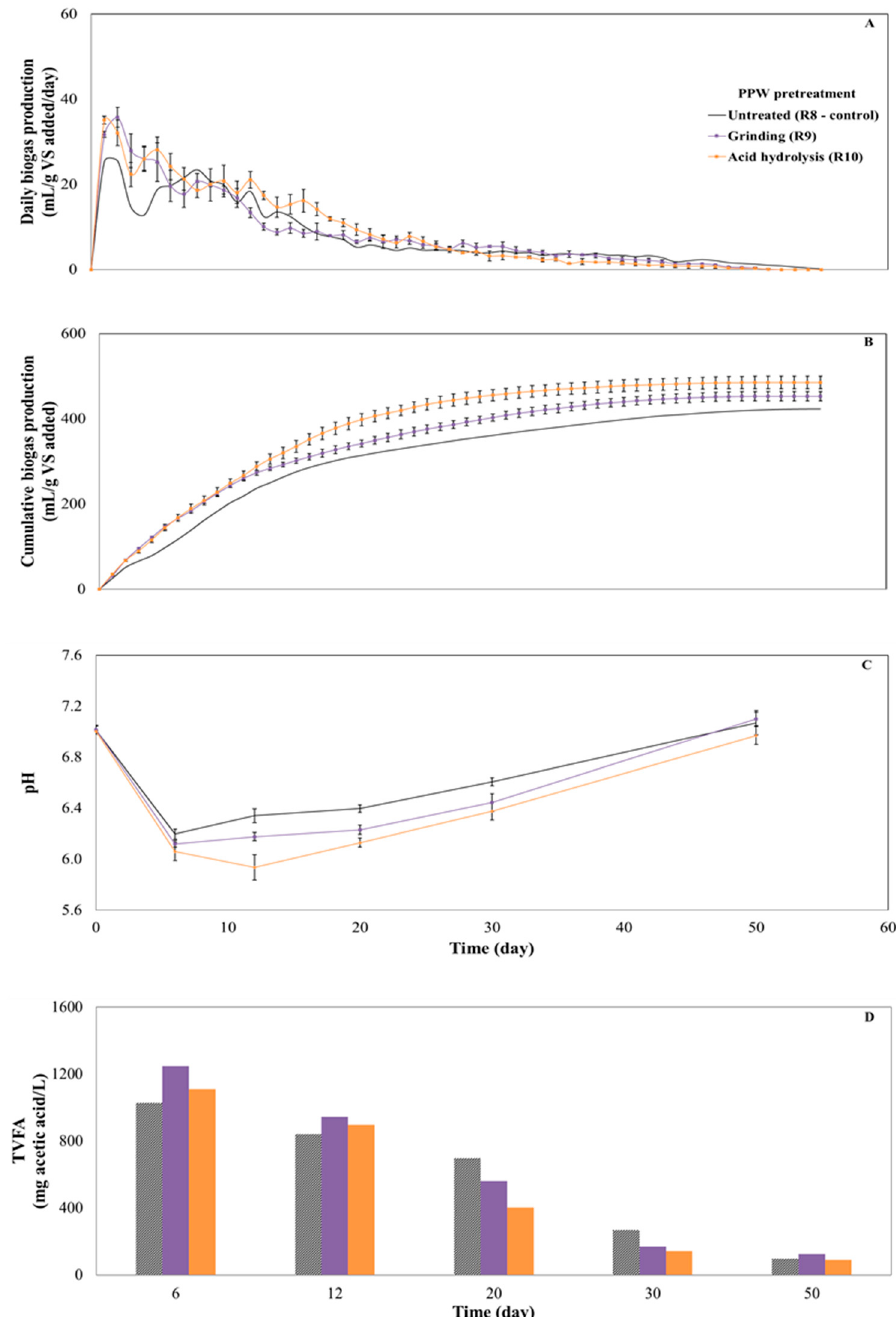
Figure 3. The effect of the pretreatment on the cumulative biogas production ( A ), the daily biogas production ( B ), the pH ( C ), and the TVFA accumulation ( D ).